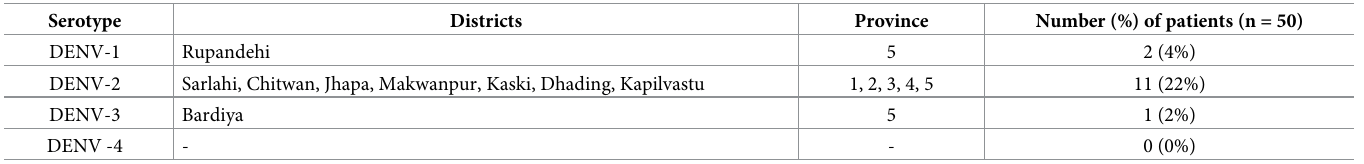
Table 3. Frequency and distribution of DENV serotypes detected by qRT-PCR and nested PCR. Serotype Districts Province Number (%) of patients (n = 50) DENV-1 Rupandehi 5 2 (4%) DENV-2 Sarlahi, Chitwan, Jhapa, Makwanpur, Kaski, Dhading, Kapilvastu 1, 2, 3, 4, 5 11 (22%) DENV-3 Bardiya 5 1 (2%) DENV -4 - - 0 (0%) See Fig 1 for Province